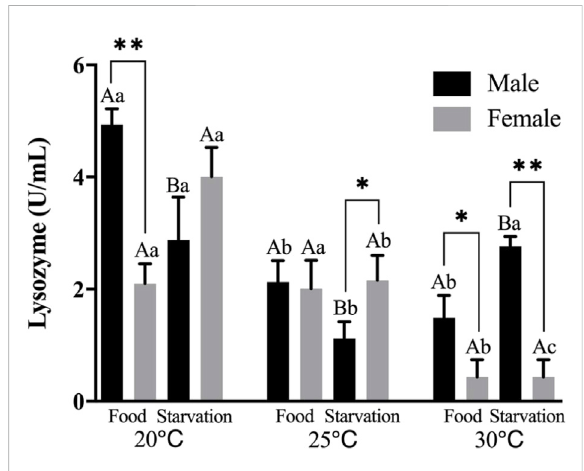
FIGURE 3 Lysozyme (LZM) of different sex M. coruscus exposed to six combinations of temperature (20, 25, and 30 ° C) and the feeding condition (food and starvation) at 30 days during the exposure period.Differentcapitallettersindicatesigni fi cantdifferences between the feeding condition and each temperature levels (20, 25, and 30 ° C) ( p < 0.05). Different small letters indicate signi fi cant differences between temperature (20, 25, and 30 ° C) and the same feeding condition ( p < 0.05). Asterisk indicates signi fi cant differences between sex and each feeding condition, in which * representssigni fi cantdifference( p < 0.05)and**representshighly signi fi cant difference ( p <